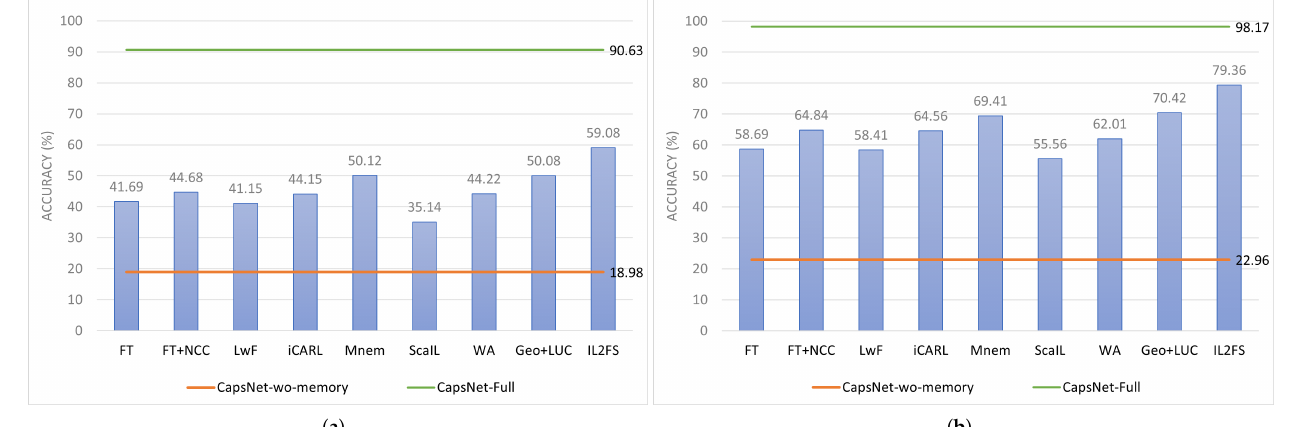
Figure 3. Comparison of CIL methods with baseline approaches on ( a ) DREAMER and ( b ) DEAP. CapsNet-wo-memory represents the average accuracy obtained by CapsNet when data from old classes are not included in the memory during the CIL training. CapsNet-Full indicates the average accuracy using all training samples from old classes in each incremental stage. Mnem and Geo+LUC indicate Mnemonics and Geodesic+LUCIR,